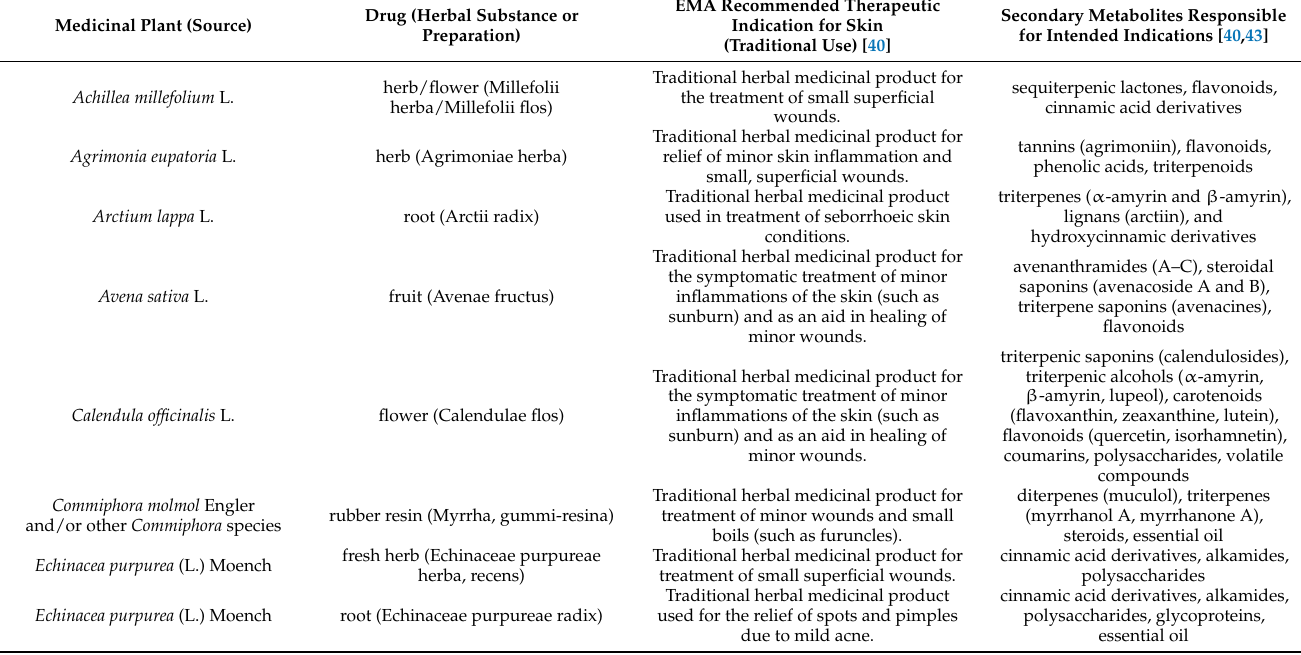
Table 2. EMA recommended herbal medicinal products with therapeutic indication for skin (Traditional use). Medicinal Plant